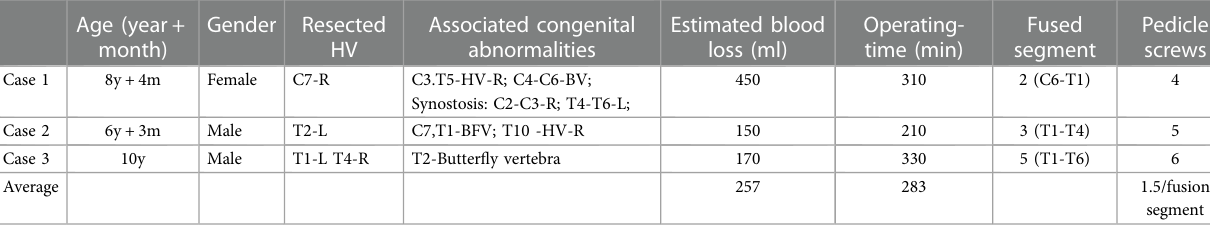
TABLE 1 Demographic anatomical and surgical characteristics.